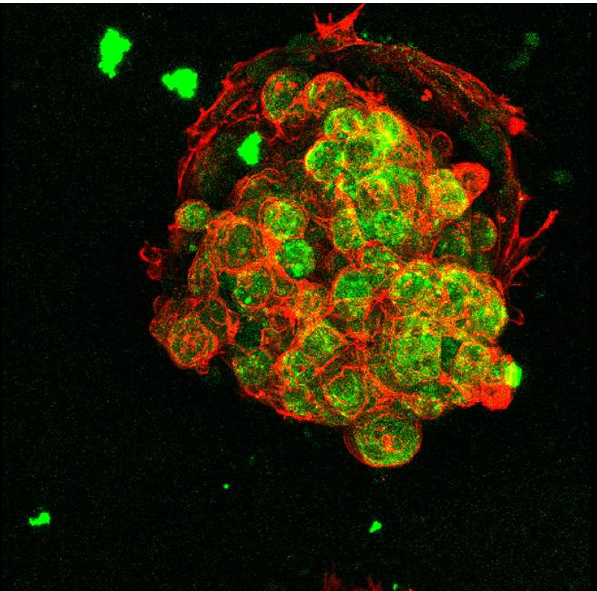
Figure 4. A 3D view of the spheroids shown in Figure 3c, underlaid with endothelial cells as a feeder layer. Adapted with permission from [30]. Copyright 2015, John Wiley and Sons.